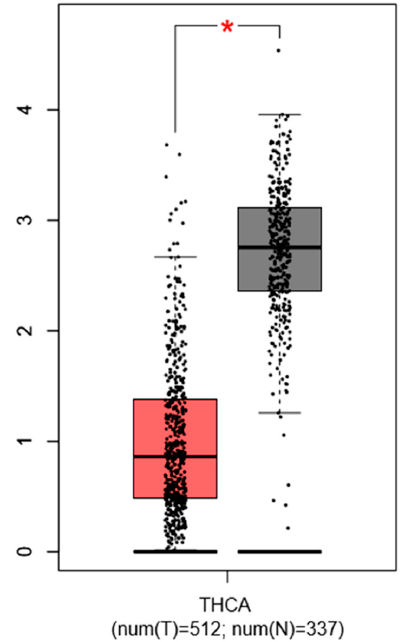
Figure 3. Expression pattern of PROX1 in thyroid cancer (THC) tissues. The red bar represents the PROX1 expression in papillary thyroid tumors (T; the number of cases = 512) and grey bar shows the PROX1 level in healthy tissues (N; the number of cases = 337), * p ≤ 0.05. The data are available on the GEPIA